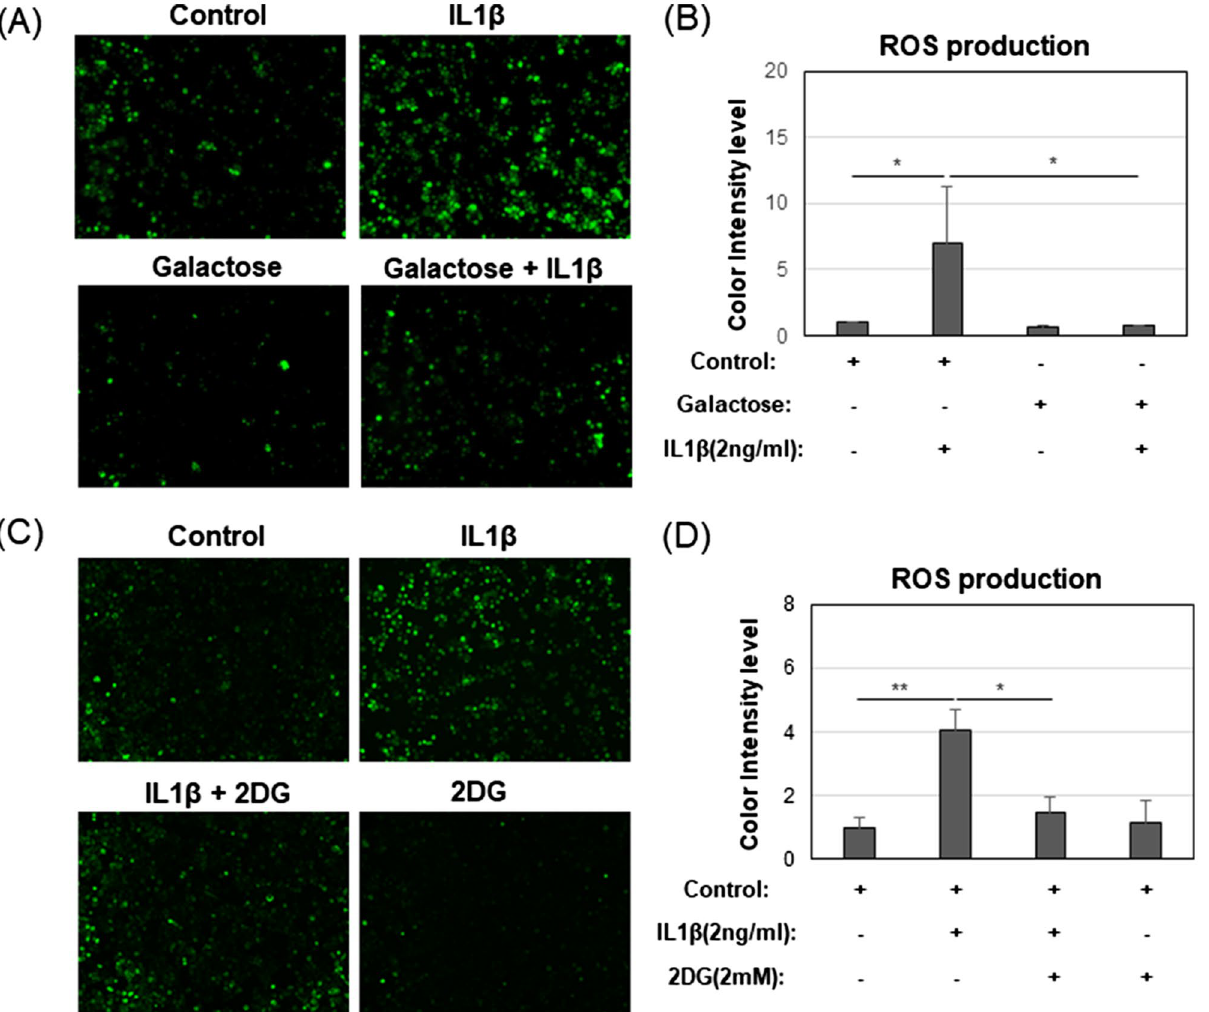
Figure 4. Galactose blocks ROS markers of mitochondrial damage. ( A ) Representative ROS Assay images for Control, IL1β, Galactose, and Galactose + IL1β culture conditions. ( B ) The quantified color intensity from ( A ) [mean ± S.D. (error bars), n = 3]. ( C ) Representative ROS Assay images for Control, IL1β, IL1β + 2DG, and 2DG. ( D ) The quantified color intensity from ( C ) [mean ± S.D. (error bars), n = 3]. ANOVA followed by Tukey post- hoc test was used for statistical analysis. *p < 0.05; **p < (DCFDA). In control chondrocytes, a few green fluorescent-positive cells were observed scattered throughout various fields of view (Fig. 4A); intensity values quantified in Fig. 4B. As expected, treatment with IL1β dramati- cally increased the number of green fluorescent-positive cells. This increase in ROS was significantly blocked in chondrocytes treated with IL1β under galactose-replaced medium culture conditions (Fig. 4A,B). These results were compared to a second series of experiments where chondrocytes were treated with or without IL1β and, with or without 2DG (Fig. 4C,D). Again, IL1β treatment caused a pronounced increase in ROS that was blocked by the presence of 2DG. Nitric oxide (NO) is another oxygen species that is altered in OA and pro-catabolically activated chondrocytes and; is one of the causes of damage to the mitochondrial electron transport system 10 . First, the expression of inducible nitric oxide synthase (iNOS) mRNA was examined by qRT-PCR. As expected, IL1β increased of iNOS mRNA relative to the expression in control chondrocytes (Fig. 5A). However, when chondrocytes were grown under galactose-replaced medium conditions, the increase in iNOS mRNA expression was blocked and, reduced below control baseline levels. iNOS mRNA levels in control chondrocytes grown in galactose-replaced medium were also ~ twofold lower than control chondrocytes grown in glucose-rich medium. In a separate series of exper- iments, the glycolysis inhibitor, 2DG also blocked IL1β induced increases in iNOS mRNA (Fig. 5D). Changes in the amount of Nitrite and Nitrate, that are inert end products of NO metabolism, were also monitored (Fig. 5B). Following the trend in iNOS mRNA, treatment of chondrocytes with IL1β generated a pronounced increase in the amount of Nitrite and Nitrate as compared to control chondrocytes (Fig. 5B). This IL1β-induced increase in the amount of Nitrite and Nitrate did not occur when the chondrocytes were cultured under galactose-replaced